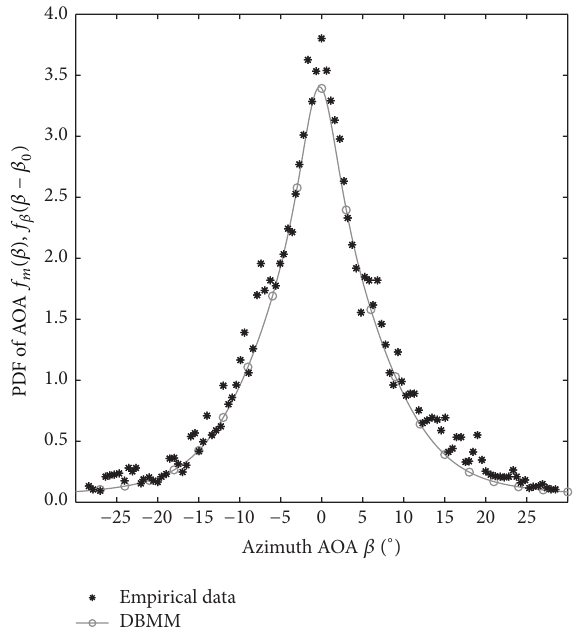
Figure 3: Comparing theoretical analysis to the empirical results in Pedersen et al. [1, Figure 4 ]